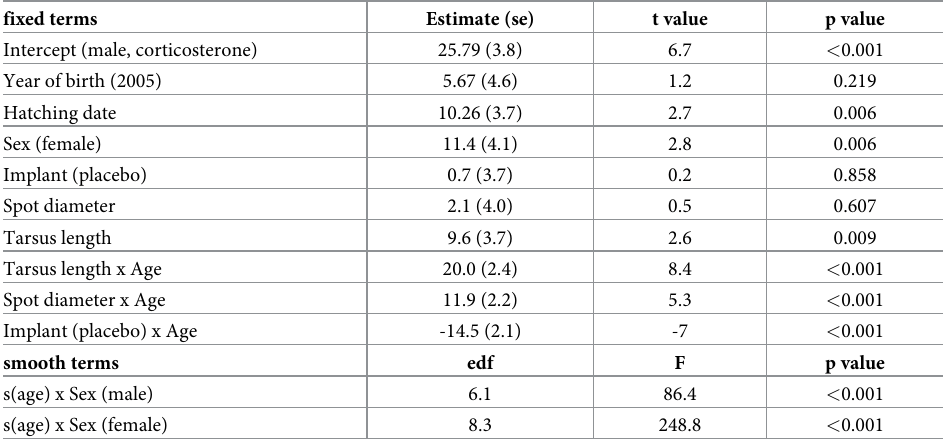
Table 2. Dispersal distance from the rearing nest in relation to year of birth (2004 or 2005), hatching date, age, sex (M = male, F = female), spot diameter, tarsus length and treatment (P = placebo, C = corticosterone) in juve- nile barn